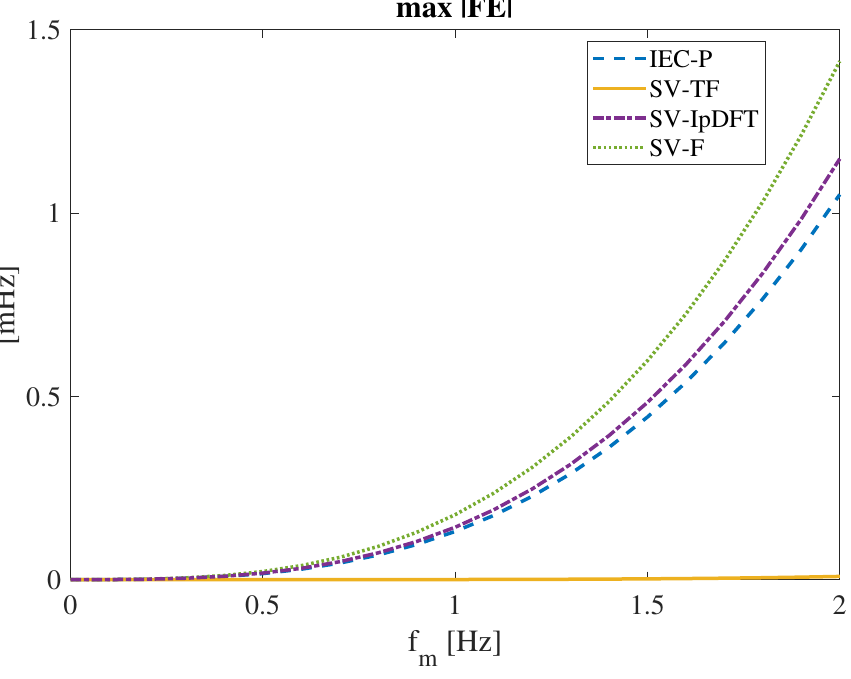
Figure 18. Maximum |FE| results under phase-angle modulations with modulation frequency f m